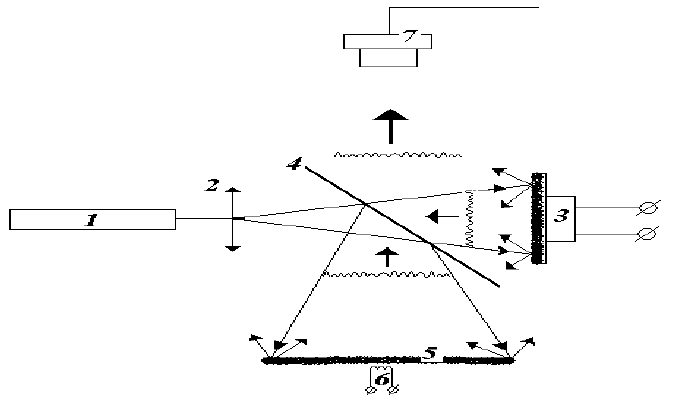
Figure 2. Scheme of the speckle